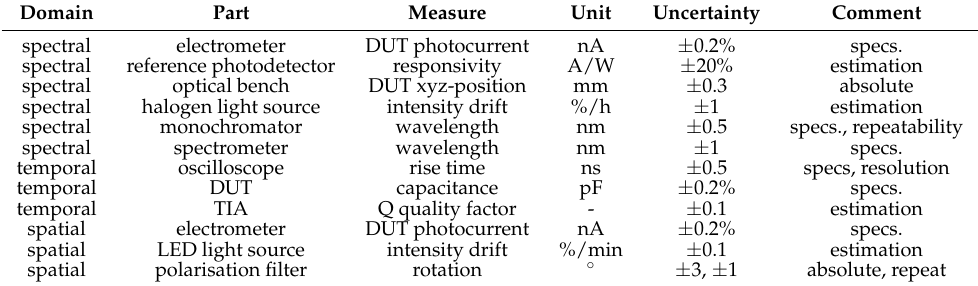
Table A1. Measurement uncertainties of most relevant parameters for the three domains